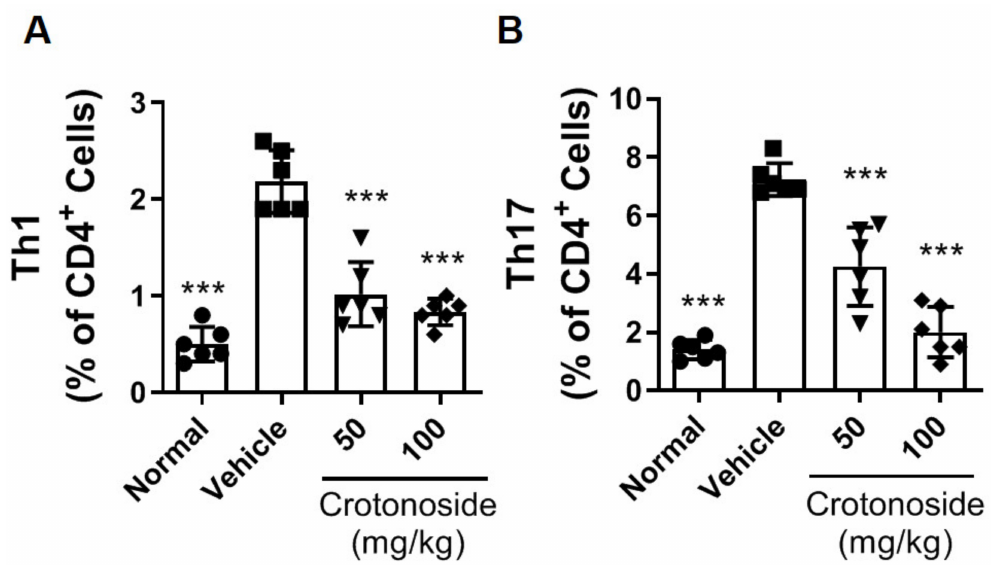
Figure 5. Reduced T cell di ff erentiation from CIA mice by crotonoside. Determination of CII-activated splenic T cell subsets treated with or without crotonoside were stained with anti-CD4 antibody followed by intracellular cytokine staining for IFN- γ , or IL-17A. The percentages of ( A ) Th1 subset (CD4 + IFN- γ + ) and ( B ) Th17 (CD4 + IL-17A + ) were determined by flow cytometry. Bar graphs represent the mean ± SD from two independent experiments where each sample represents a pool of six mice. *** p < 0.001, versus CIA / PBS group, as determined by a one-way ANOVA with Dunnett